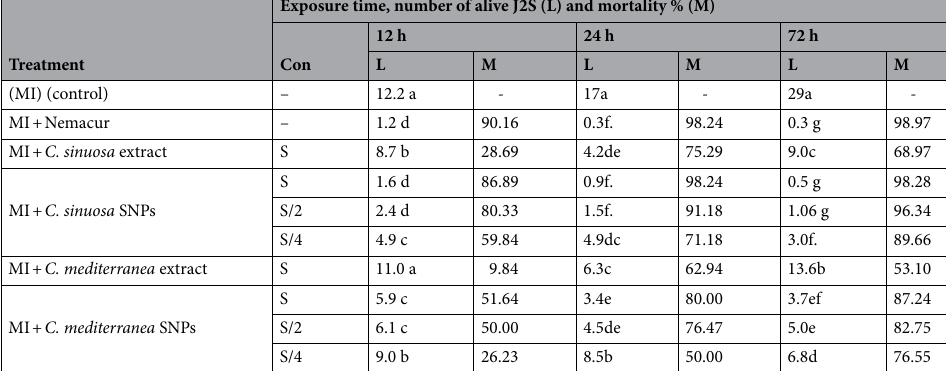
Table 1. The effects of Colpomenia sinuosa , Corallina mediterranea macroalgal extracts and synthesized silver nanoparticles on J2s mortality % (M) of Meloidogyne incognita (MI) after 12, 24 and 72 h of exposure. * Data are means of 5 replicates. Means with the same letter(s), in each column, are not significantly different at P ≤ 0.05., L = Live. M = Mortality % = [(Total number of a live J2S in control—No. of alive J2S in treatment) / No. of Total alive J2S in control] ×